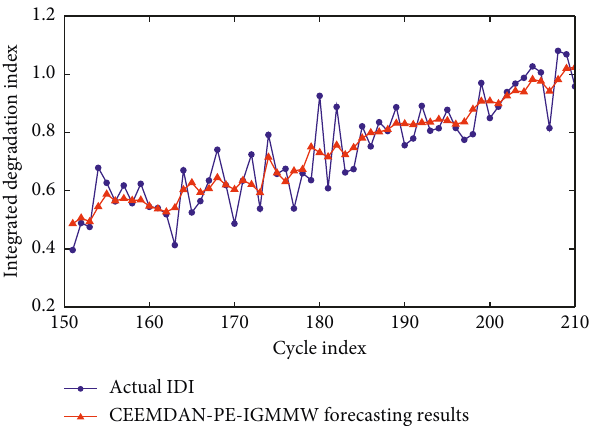
Figure 12: Comparisons of actual IDI and forecasting results of the proposed CEEMDAN-PE-IGMMW method.